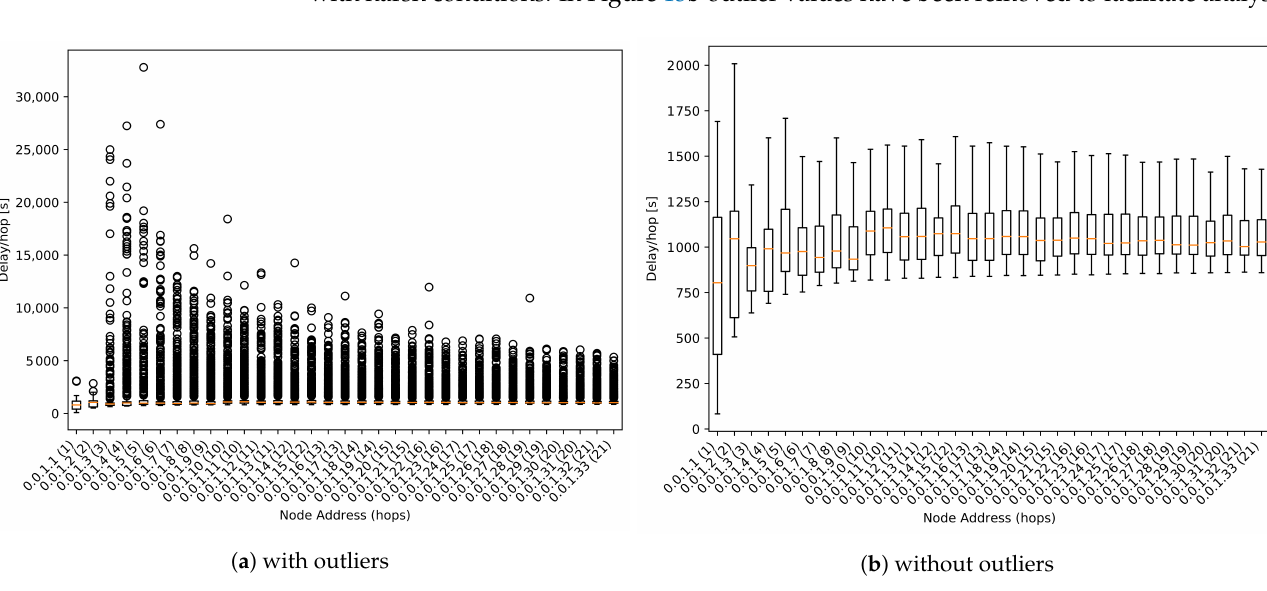
Figure 13. One-way delay